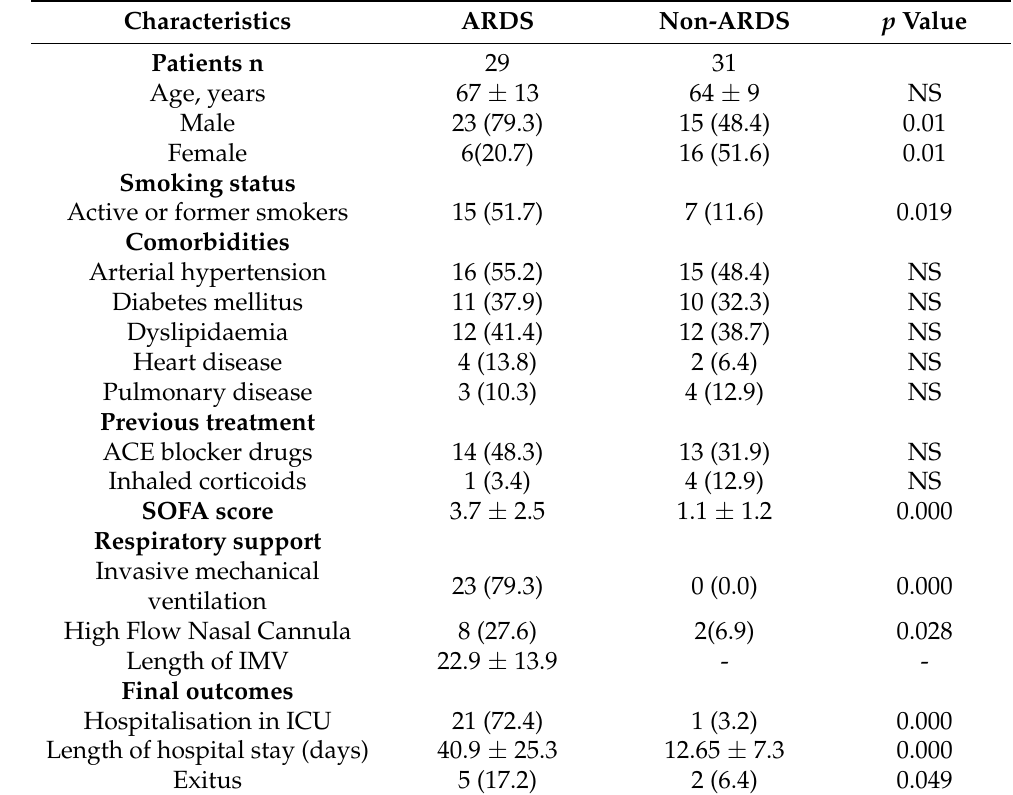
Table 1. Baseline demographic and clinical characteristics and final outcomes of the patients who developed acute respiratory distress syndrome, or pneumonia without this